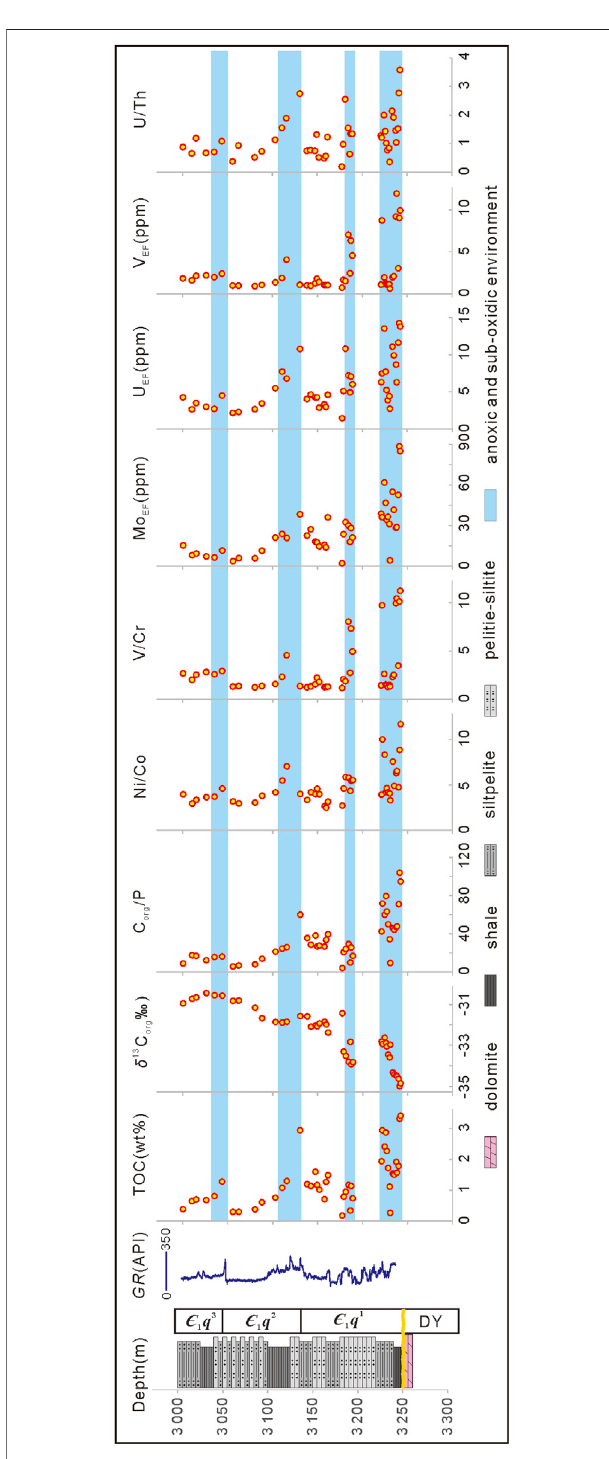
FIGURE 7 | Characteristics of the paleo-marine environment (redox parameters) of the Qiongzhusi Fm, W-207 Well. Є 1 q 1, 2,3 : fi rst, second and third member of Qiongzhusi